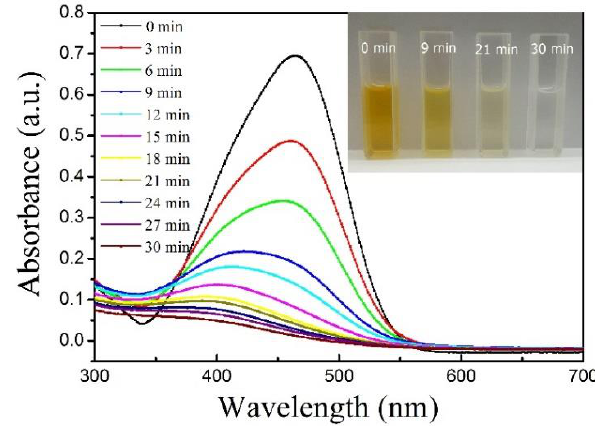
Figure 4. Change in absorbance and color of methyl orange solution with photocatalytic degradation time.